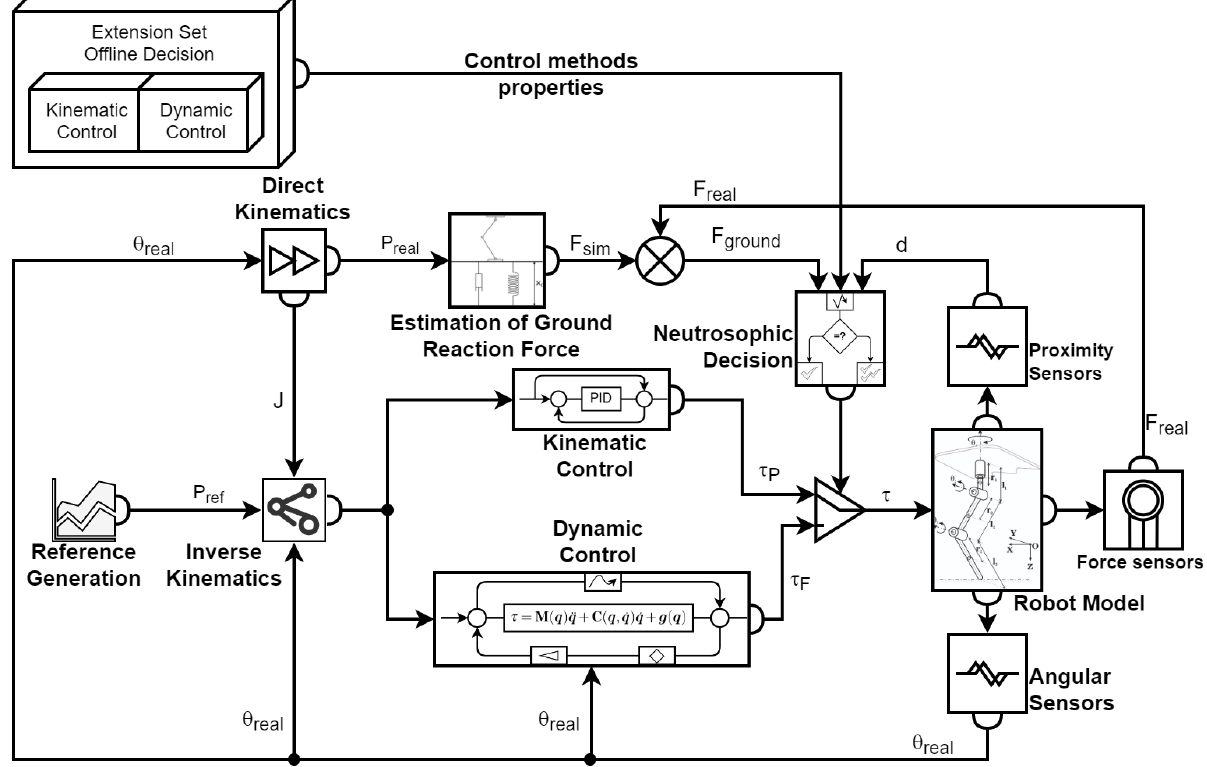
Figure 4. The general control diagram.